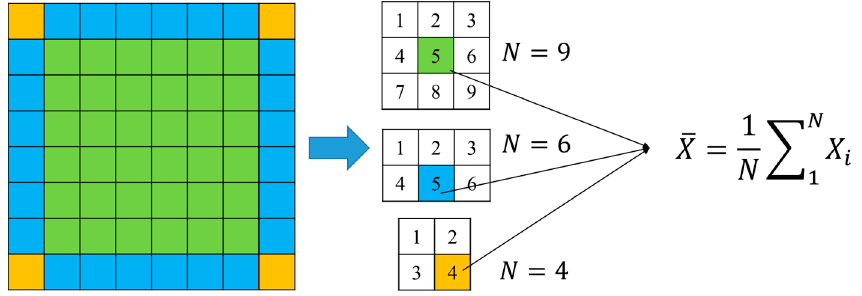
Figure 13. The method of homogenization to make the image smoother.